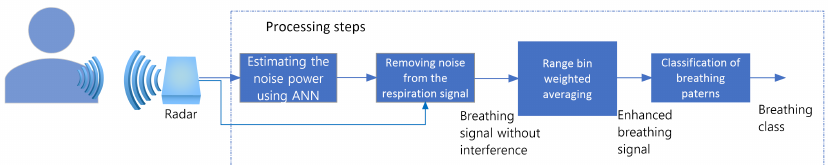
Figure 2. Processing stages including breathing signal recovery (first 2 processing blocks), signal enhancement block and classification of breathing patterns.